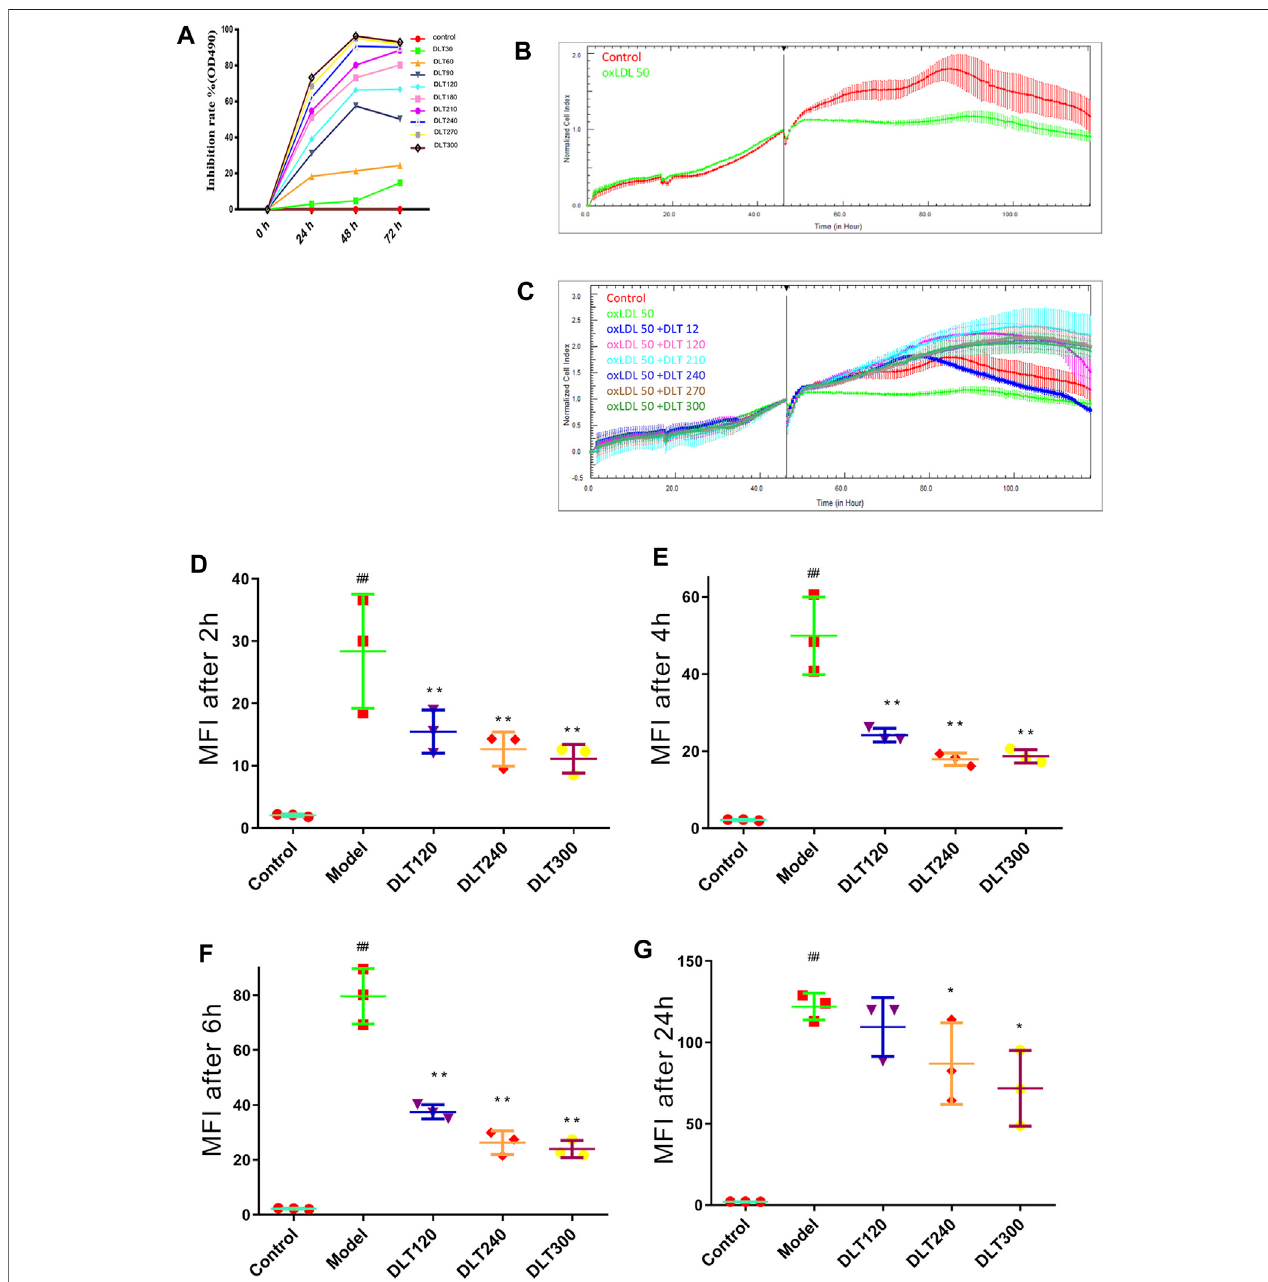
FIGURE 6 | DLTs affected the viability and phagocytosis of Dil-oxLDL in RAW264.7 cells. (A) Viability of RAW264.7 cells treated with DLTs. (B) CI of RAW264.7 cells treated with ox-LDL. (C) CI of RAW264.7 cells treated with DLTs and ox-LDL. (D – G) The extent of Dil-oxLDL uptake (MFI) by RAW264.7 cells after treatment with DLTsfor2,4,6and24 hwasdeterminedby fl owcytometry,andtheresultsareshownasbargraphs.Thedataarepresentedasthemean ± SD, ## p < 0.01vsthecontrol group, and *p < 0.05, ** p < 0.01 vs the model